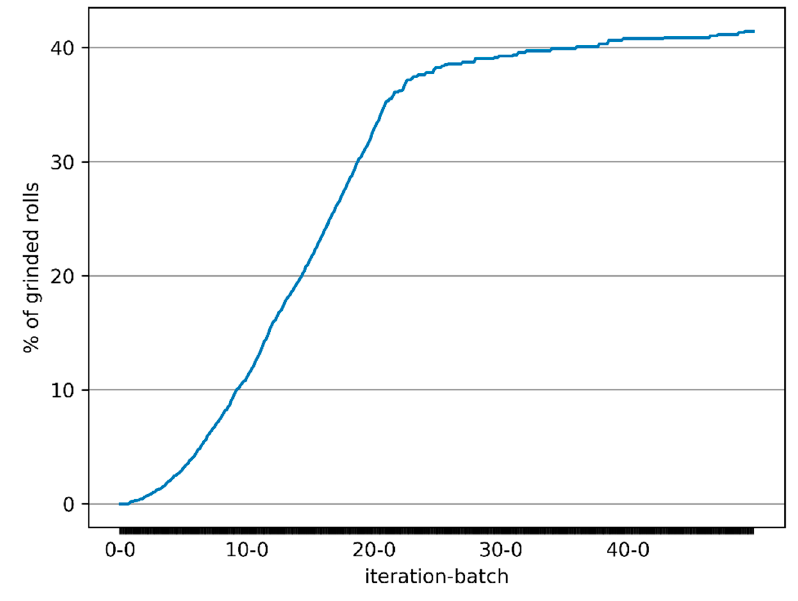
Figure 6. Percentage of rolls